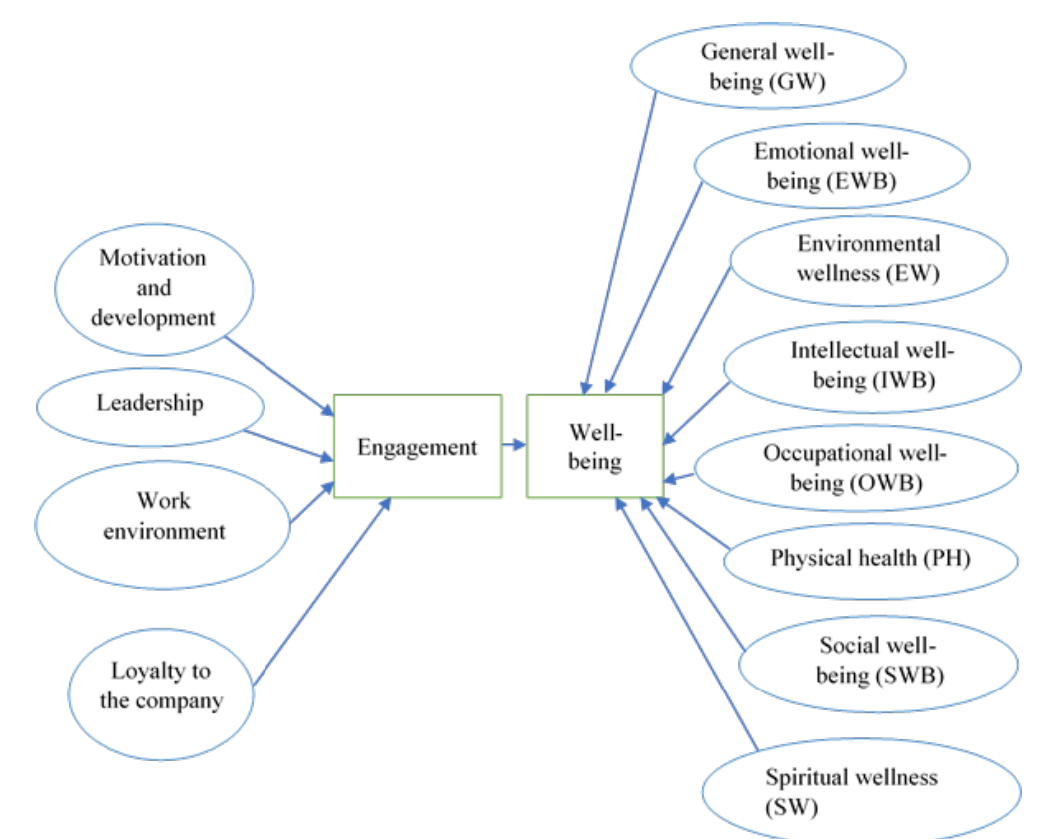
Figure 2. Theoretical-conceptual model regarding the relationship between EE and WB. Source: Developed by the authors.